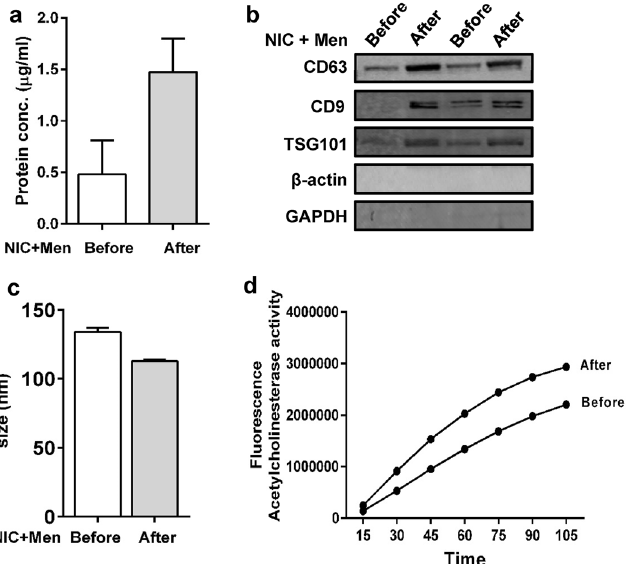
Figure 1. ( a – c ) Characterization of EVs using representative rat plasma EV samples ‘before’ and ‘after’ nicotine self-administration. ( a ) Protein quantification of rat plasma EVs obtained ‘before’ and ‘after’ self-administered nicotine with menthol cue (n = 2). ( b ) EVs were characterized using markers such as CD63, CD9, and TSG101 ‘before’ and ‘after’ self-administered nicotine with menthol cue. Cellular proteins such as β-actin and GAPDH were used as negative control (representative western blots, n = 2). ( c ) Comparison of EV size ‘before’ and ‘after’ self-administered nicotine with menthol cue (n = 2). ( d ) Acetylcholinesterase (AChE) activity was measured in rat plasma EVs. 10 µl plasma was used to isolate EVs from rat plasma. Graphs represent time-dependent curve of AChE activity of the rat plasma EVs isolated from samples ‘before’ and ‘after’ nicotine self-administration (n =